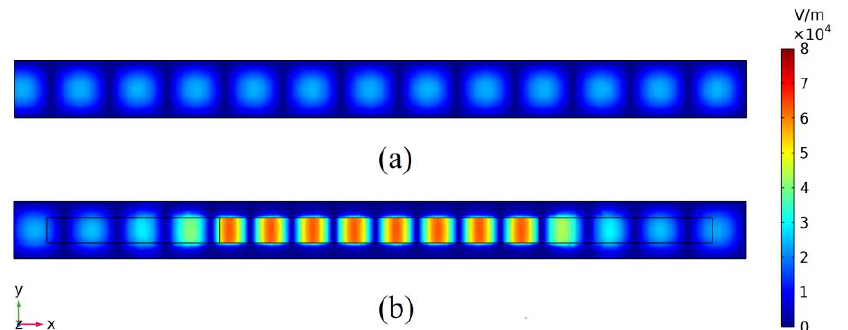
Figure 5. The electric field distribution in the conventional waveguide and double-ridged waveguide in the cross-section of z = 0 mm without load. ( a ) WR340; ( b ) Double-ridged waveguide.